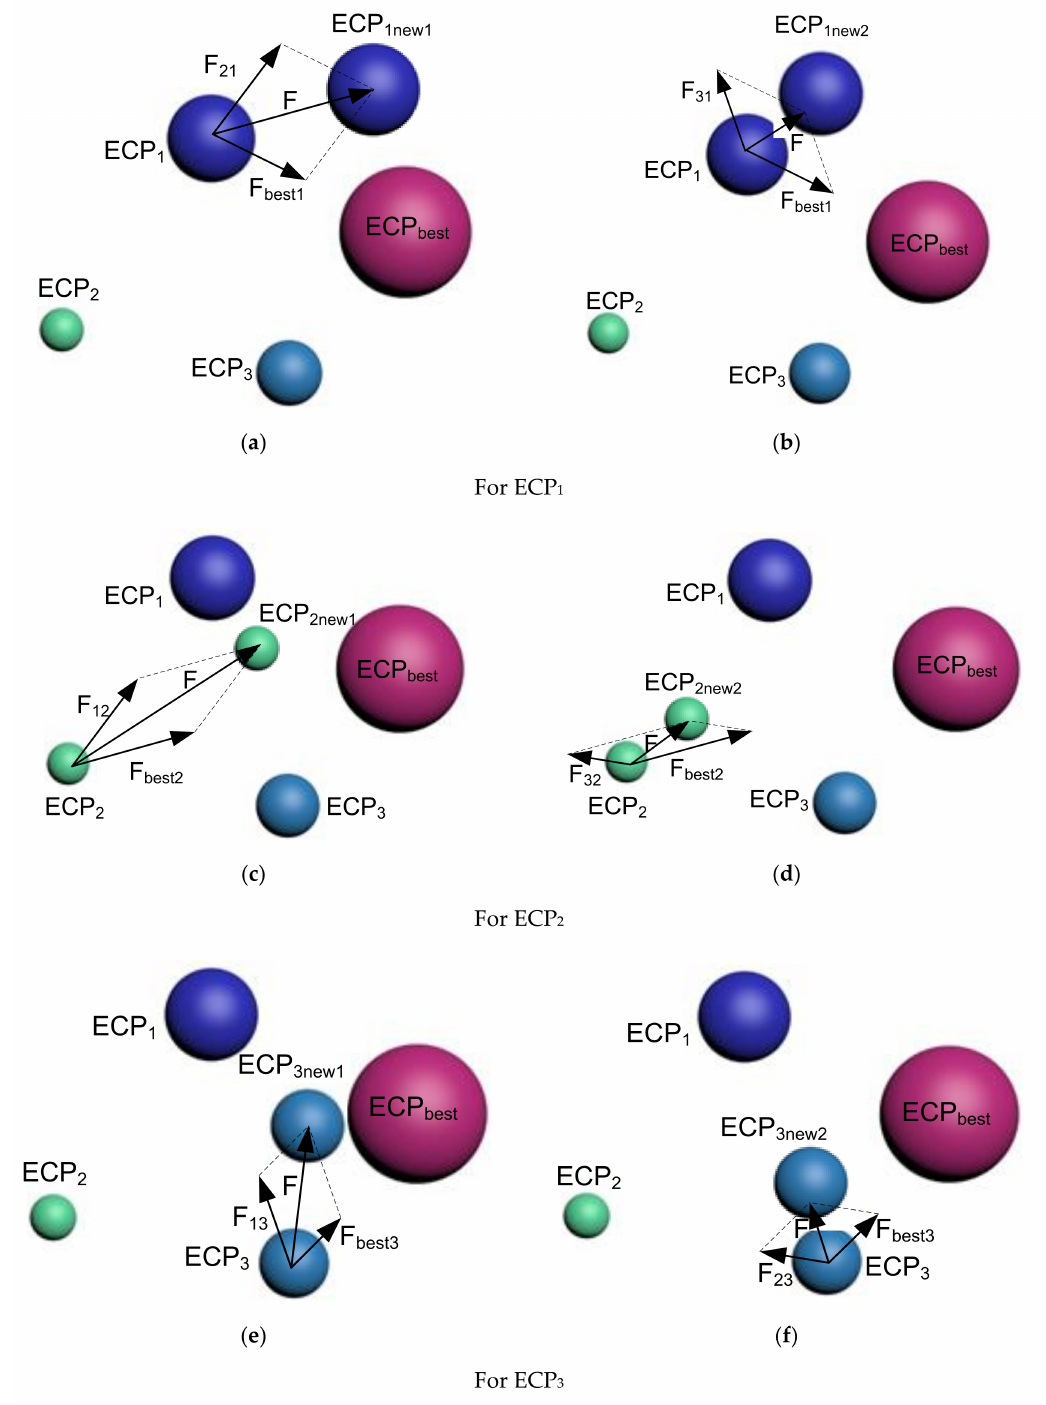
Figure 1. Illustration of the interaction between ECPs for strategy